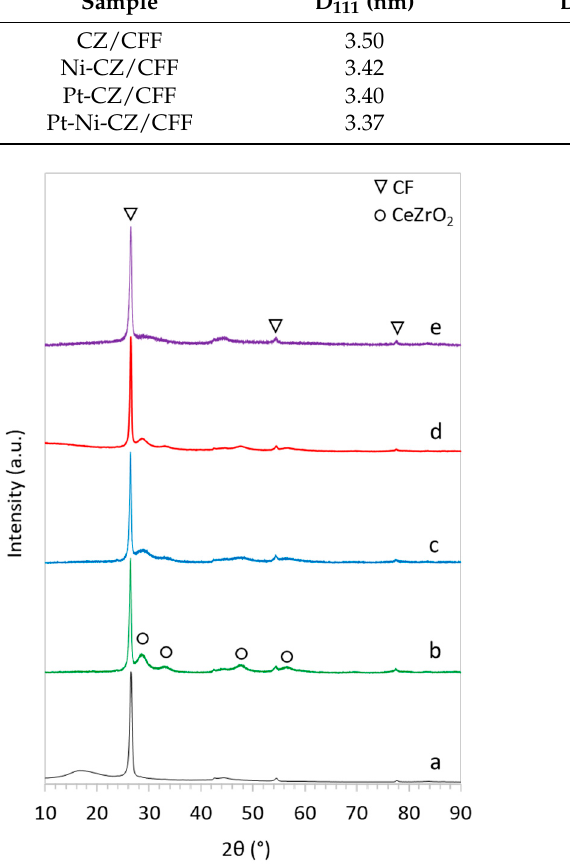
Figure 1. X-ray diffraction (XRD) patterns of CFF ( a ), CZ/CFF ( b ), Ni-CZ/CFF ( c ), Pt-CZ/CFF ( d ), and Pt-Ni-CZ/CFF ( e ).